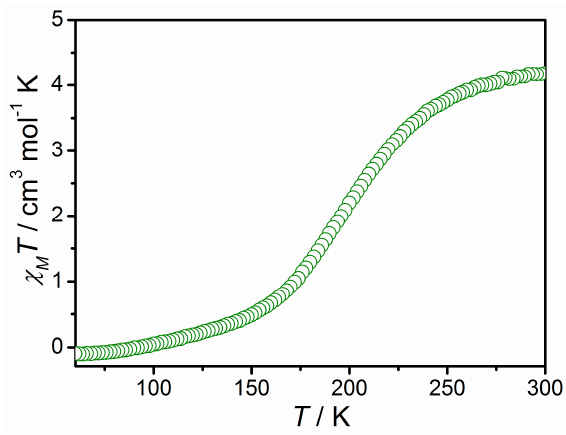
Figure 6. The χ M T value of the Fe2 ion is obtained by subtracting the contributions of the [Fe II3 ( μ 3 -O)] 4+ core and the dinuclear anion from 1.